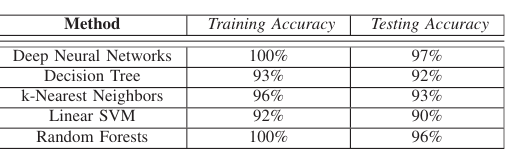
Method Training Accuracy